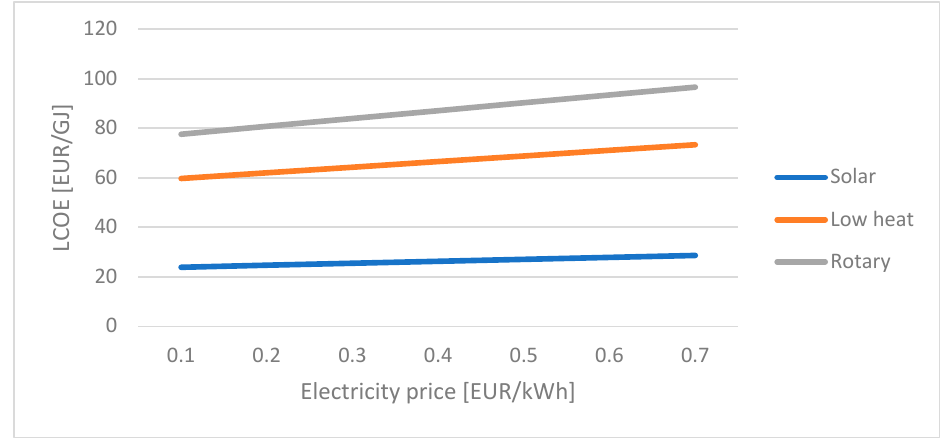
Figure 2. Sensitivity analysis on electricity price.